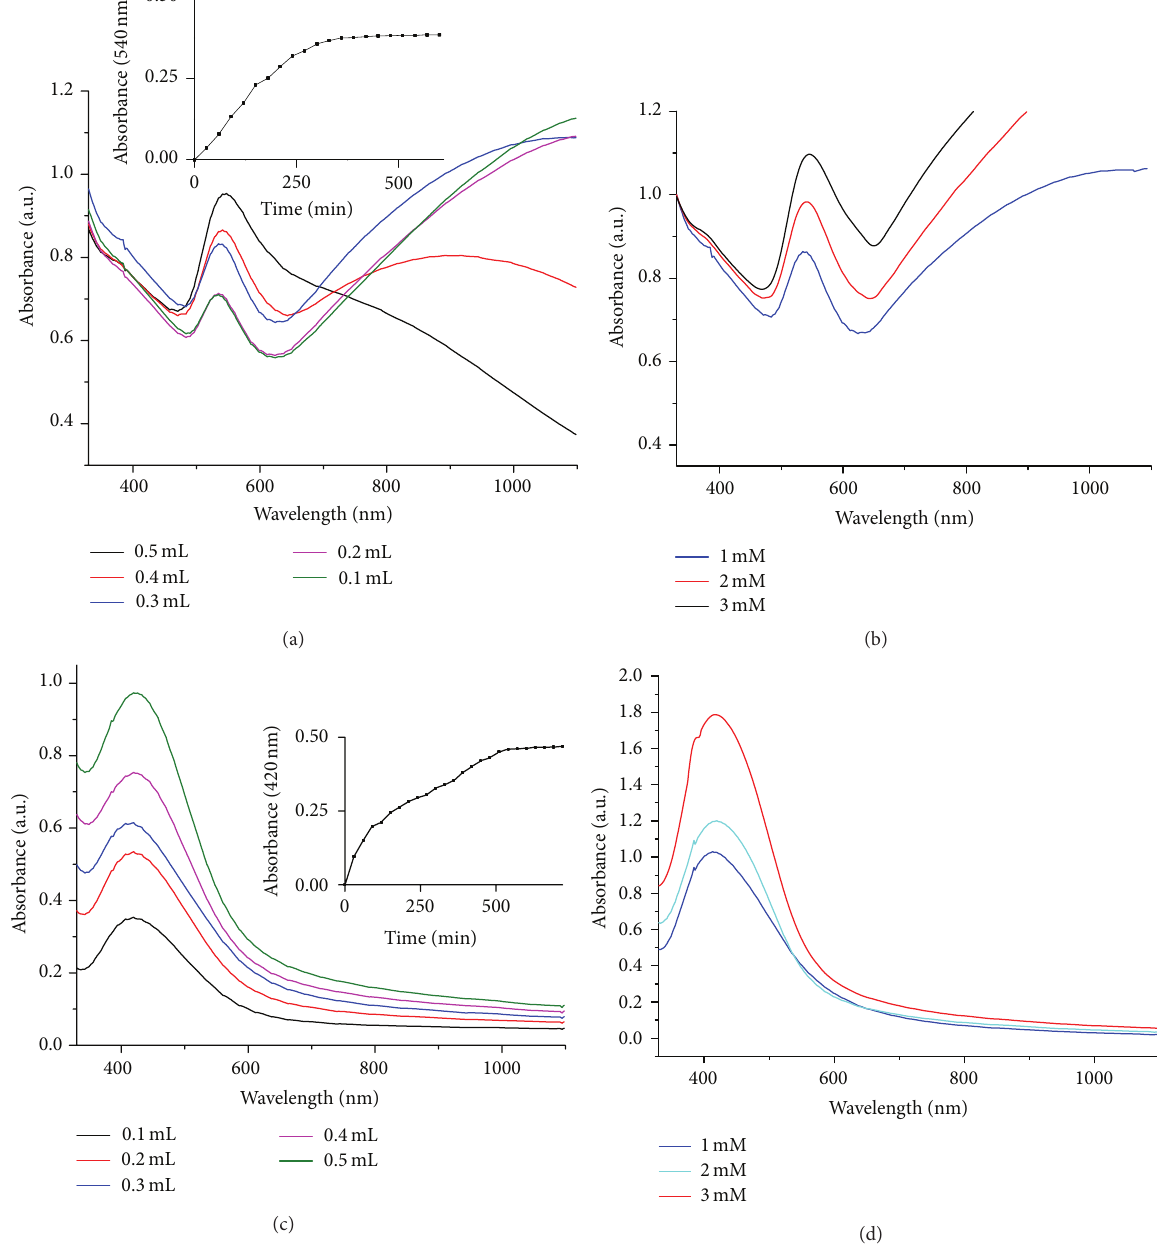
Figure 2: Effect of ABE extract with 1mM metal salt concentration. (a) In synthesis of gold nanoparticles. (c) In synthesis of silver nanoparticles. Effect of metal ion concentration. (b) In synthesis of gold nanoparticles. (d) In synthesis of silver nanoparticles. Inset of (a) and (c), respectively, shows the change in SPR intensity over time for gold and silver nanoparticles